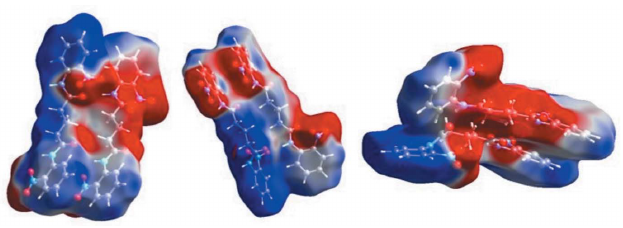
Figure 5 View of the Hirshfeld surface mapped over the electrostatic potential for the two molecules ( A and B ).